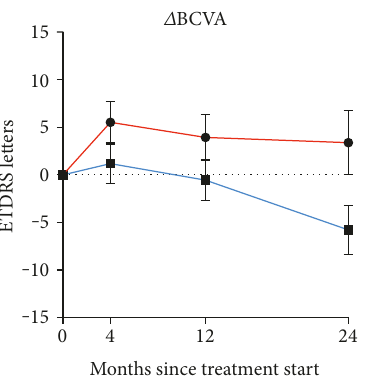
Figure 2: Change in best-corrected visual acuity of eyes with neovascular age-related macular degeneration in patients aged ≥ 90 years treated with either A fl ibercept (red) or Ranibizumab (blue). Dots and whiskers indicate mean and standard error.